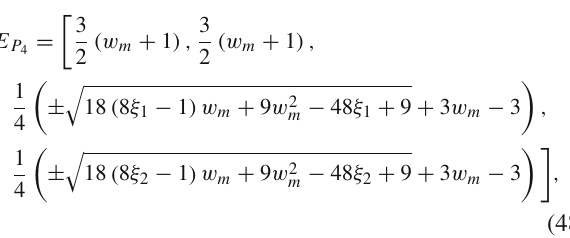
tive equation of state is equal to the barotropic parameter w m .